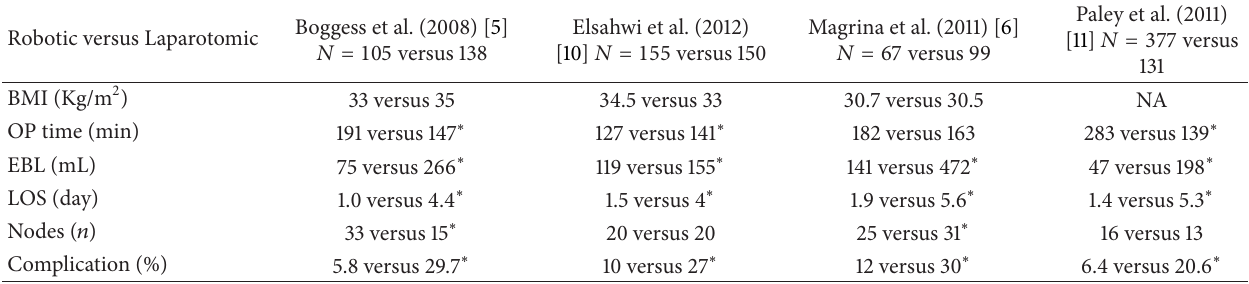
Table 6: Robotic versus laparotomic hysterectomy and staging endometrial cancer. Robotic versus Laparotomic